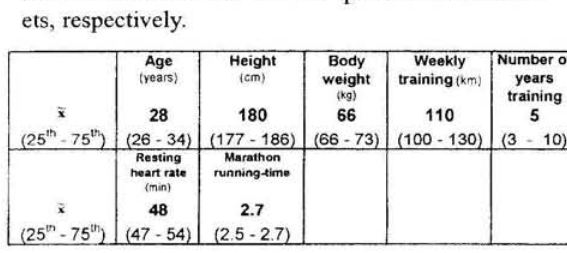
Table 1: Anthropometric data, training status and marathon running time of the runners. Data shown as median values and 25" and 75 (h percentiles in brack- ets, respectively.